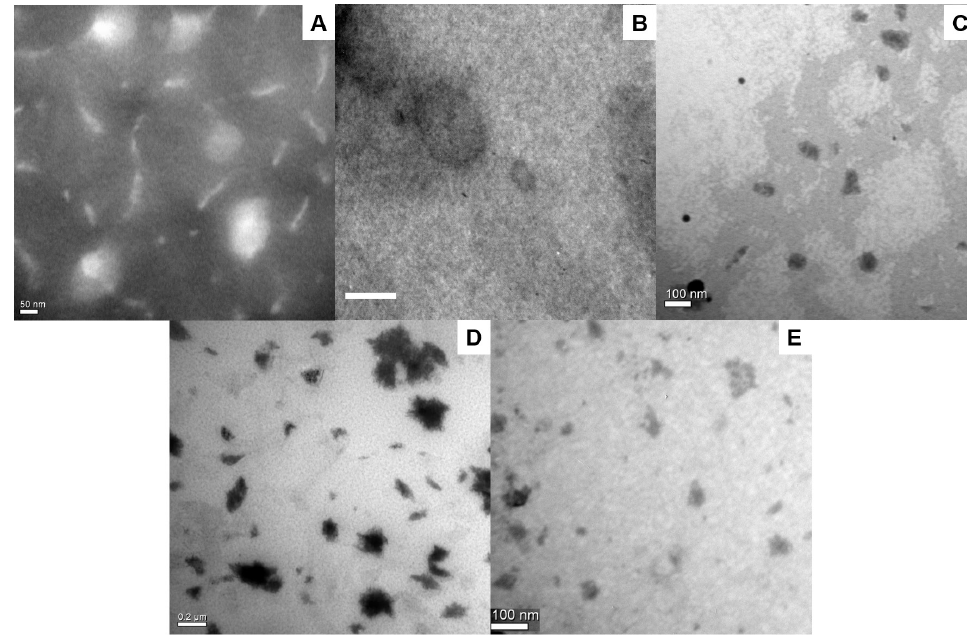
Figure 1. TEM micrograph of ( A ) UET-Vis (150,000×), ( B ) UDL-Vis (50,000×), ( C ) C-Vis (80,000×), ( D ) M-Vis (60,000×), and ( E ) DG4-Vis (100,000×). The reference bar corresponds to ( A ) 50 nm, ( B ) 100 nm, ( C ) 100 nm, ( D ) 200 nm, and ( E ) 100 nm. TEM micrograph of UDL-Vis can be found in reference [5].